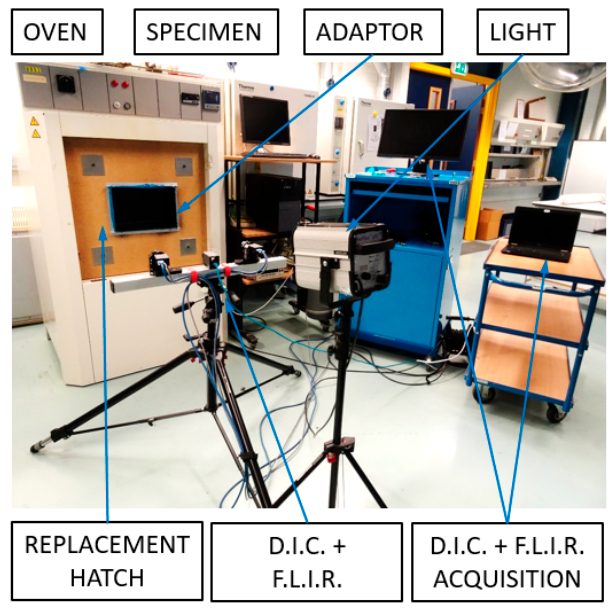
Figure 10. Test setup.